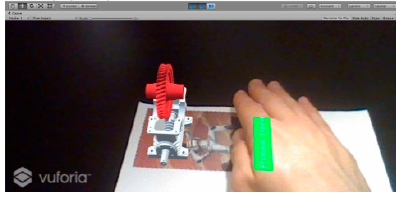
Figure 35. Animated disassembling gearbox.